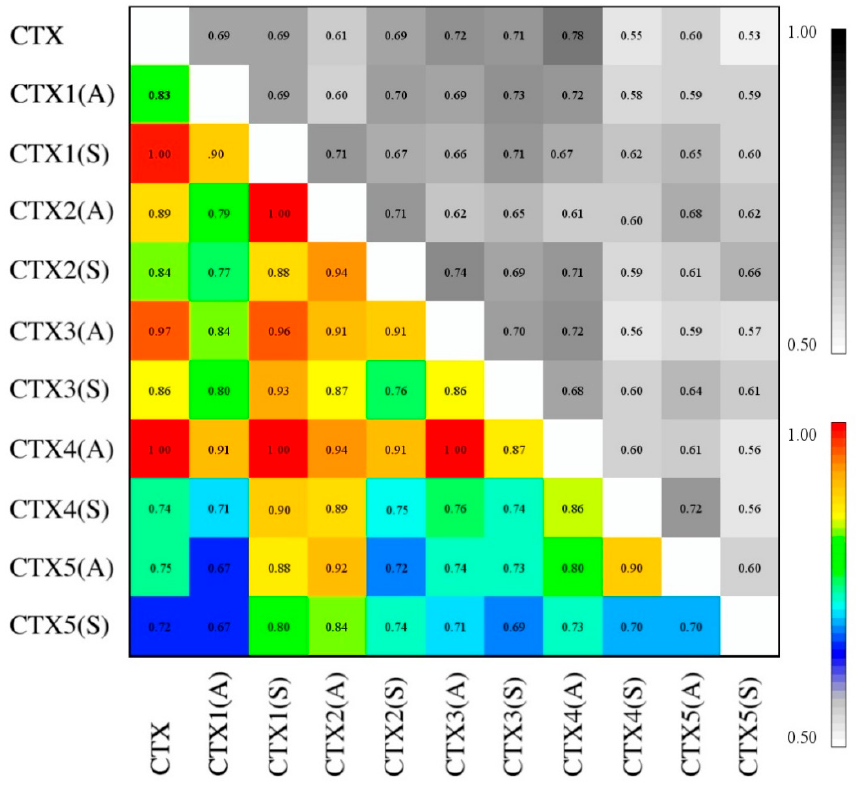
Figure 6. Comparison of essential subspace sampling. Root-mean-square inner product (RMSIP, top right in grayscale) and normalized RMSIP (bottom left in color) matrix of trajectories of molecular dynamics simulation of CTX and its Abu- and Ser- substituted analogs. By definition, the diagonal values equal 1.0, but not color-coded for clarity.